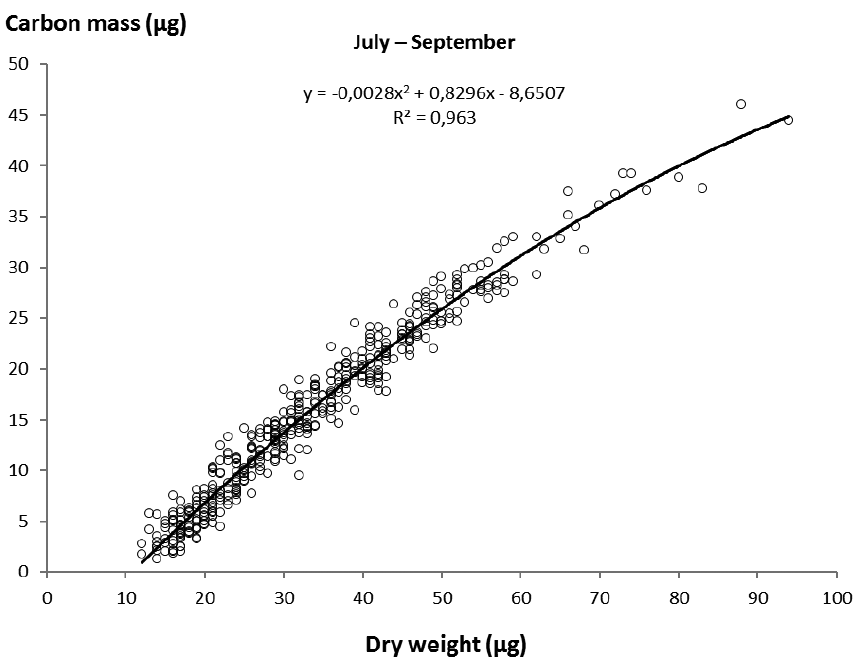
Figure 3. Relationship between carbon mass (µg) and dry weight (µg) of Cercopagis pengoi for July –